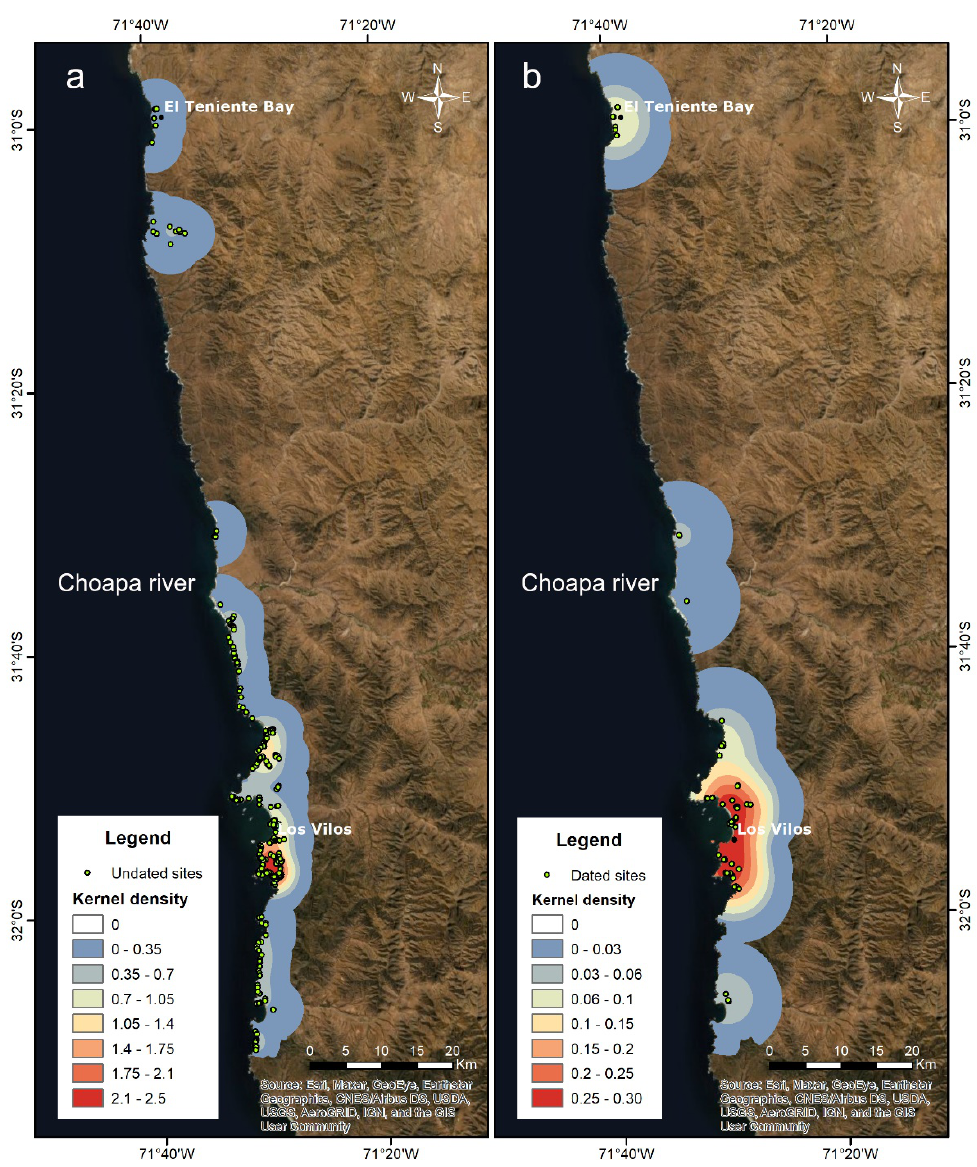
Figure 8. Density of coastal archaeological records from 31° to 32° S: ( a ) undated sites; ( b ) dated sites.